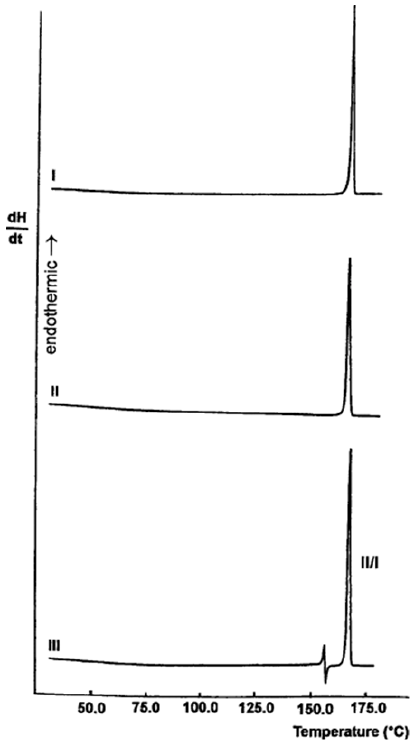
Figure 6. DSC curves of different D -mannitol polymorphs (heating rate 5 K min − 1 ). (I) α form of mannitol, (II) β form of mannitol, and (III) δ form of mannitol. Reprinted from Ref. [42] Copyright 2000, with permission from Elsevier.